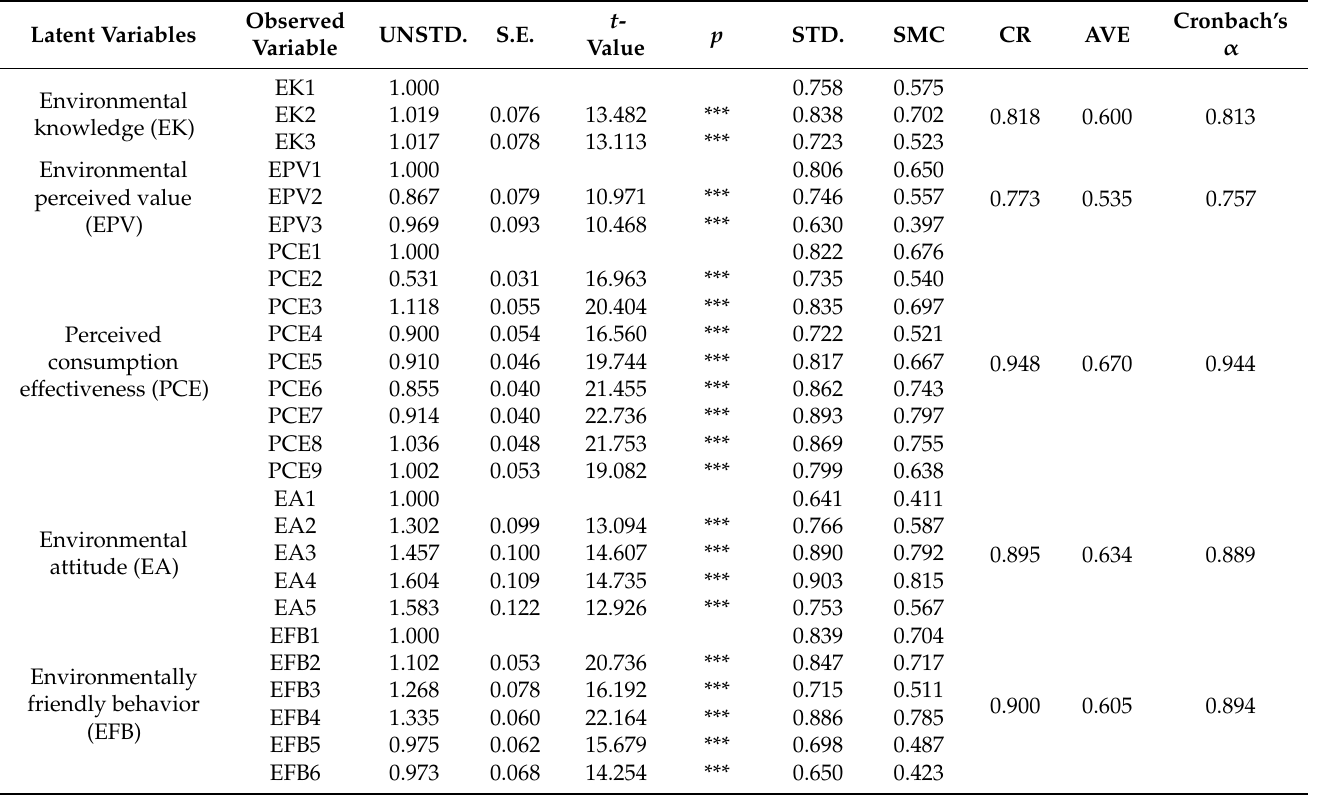
Table 3. Internal and convergent reliability. AVE: Average variance